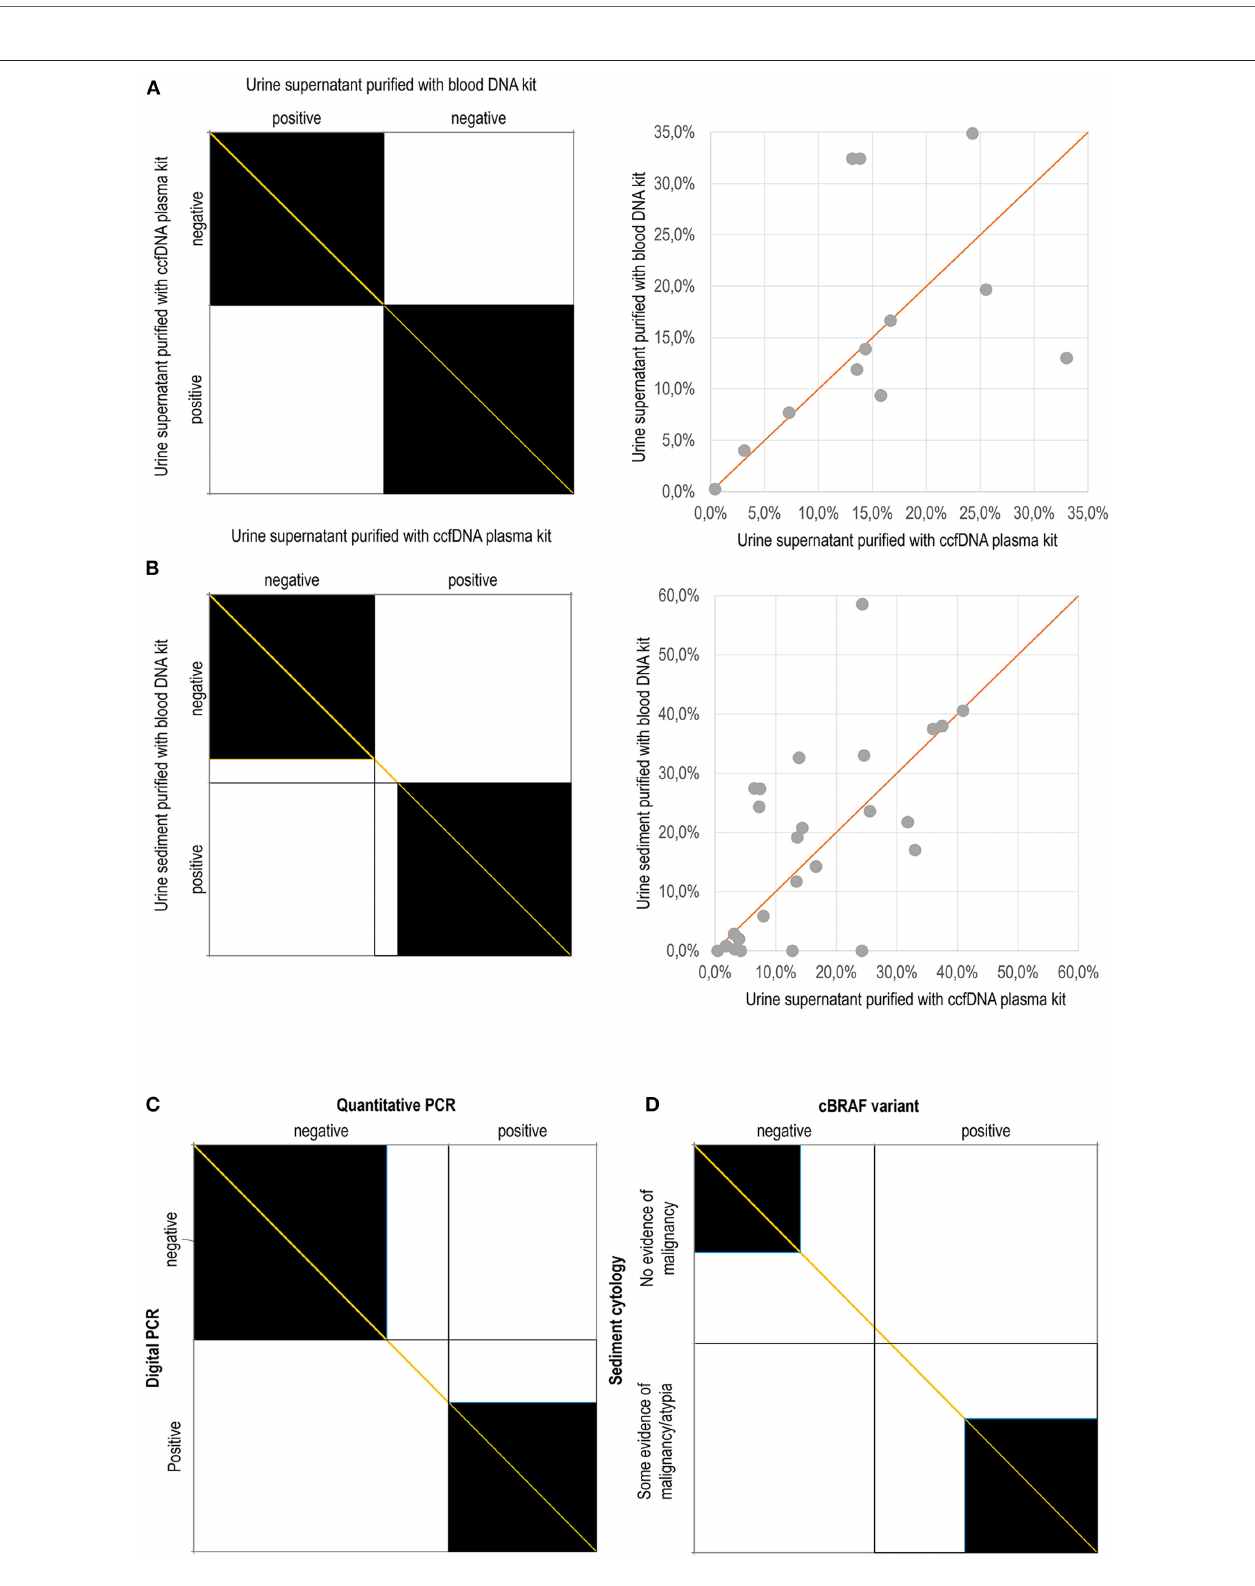
FIGURE 4 | Agreement charts according to Bangdiwala and Shankar (23): The agreement chart provides a visual representation for comparing the concordance in paired categorical data. Agreement is determined by the size of the box. Lesser agreement is visualized by comparing the area of the blackened squares to the area of the rectangles. The direction of method bias is reviewed by examining the “path of the rectangles” and how it deviates from the diagonal line of no bias (orange).